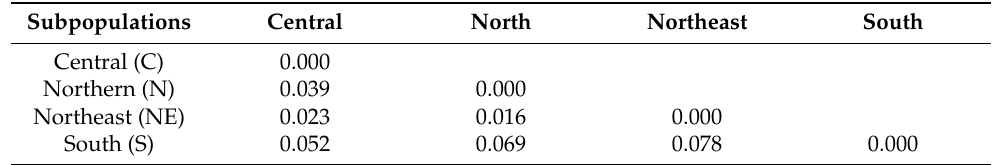
Table 4. The pairwise population F ST analysis of the four subpopulations grouped by region of